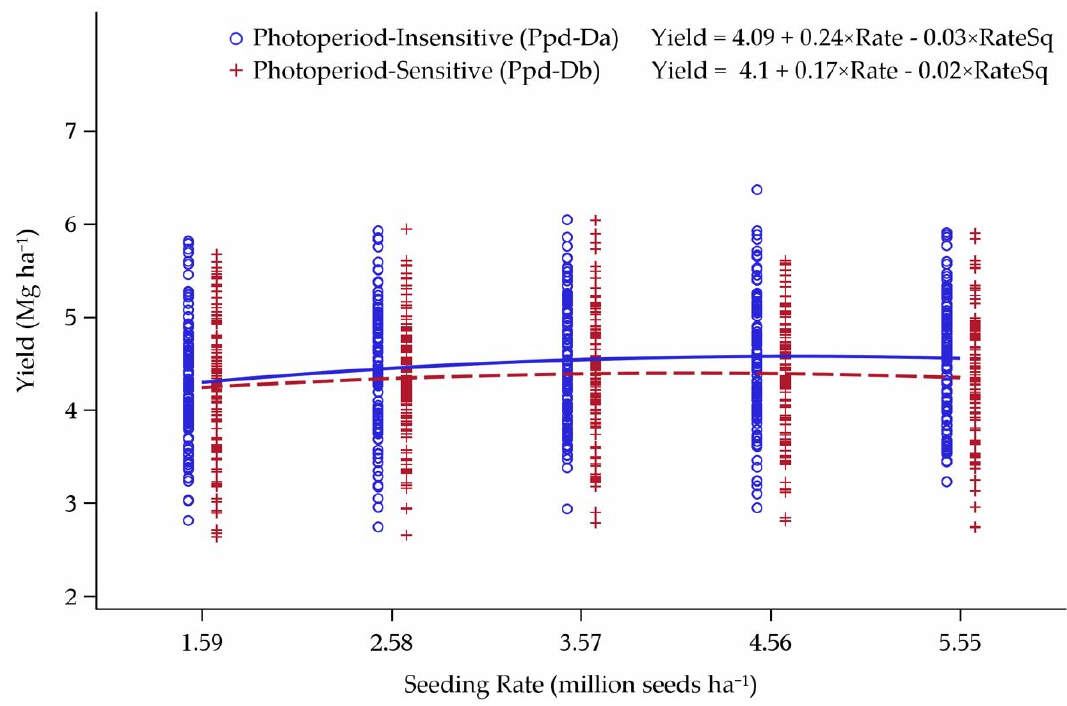
Figure 12. Influence of Ppd-D alleles on yield response to seeding rate over the six lowest-yielding environments in Minnesota and North Dakota, 2013–2015. Seeding rate for the peak of the curve: Ppd-Da = 4.21 and Ppd-Db = 3.71 million seeds ha − 1 .